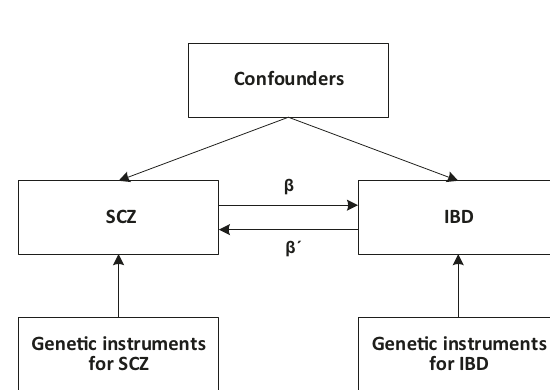
Fig. 2 Bidirectional Mendelian randomization study design. β is the causal effect of genetic instruments of SCZ on IBD, whereas β ´ is the causal effect of genetic instruments of IBD on SCZ. SCZ schizophrenia, IBD in fl ammatory bowel